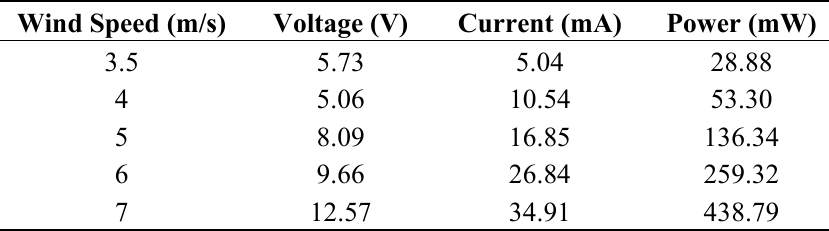
Table 6. Outputs at the maximum power points.